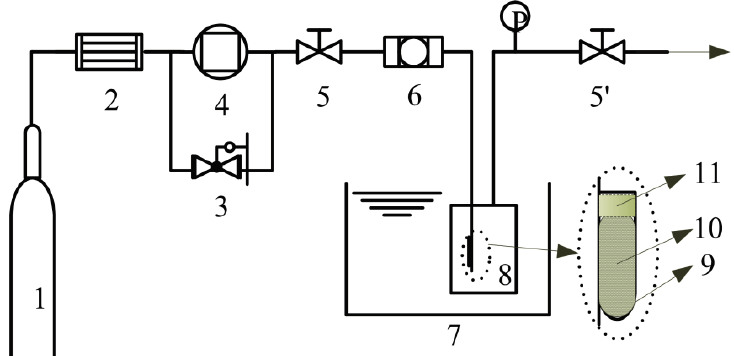
Figure 7. Schematic diagram of the solute-saturated supercritical loading process; (1) CO 2 cylinder; (2) dryer; (3) back pressure valve; (4) compressor; (5,5’) valves; (6) filter; (7) water bath; (8) loading vessel; (9) tube ; (10) ibuprofen loaded; (11) cotton; (P) pressure